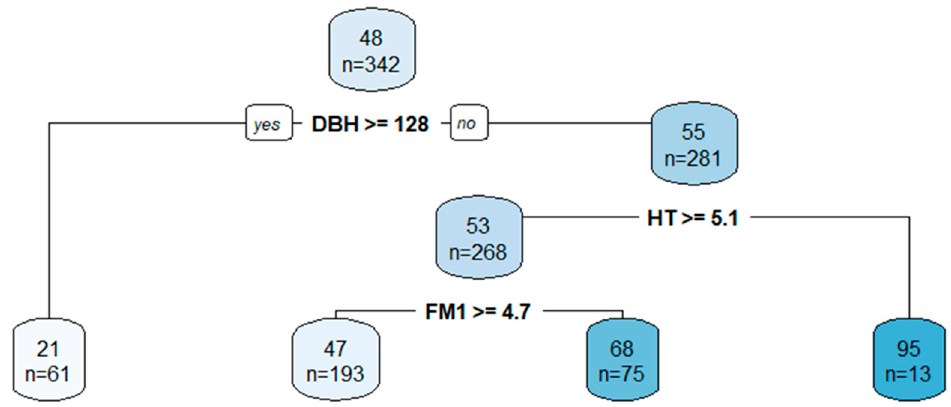
Figure 4. Pruned regression tree of pre-fire stand measurements, remote automated weather stations (RAWS) weather, and modeled attributes on fire-induced mortality as a percent of pre-fire, live tree basal area. Pruned tree contains mean stand dbh (cm), stand height (m), one-hour fuel moisture (FM1—percent water by weight); boxes contain mortality and number of FIA stands, defined as conditions (see methods).